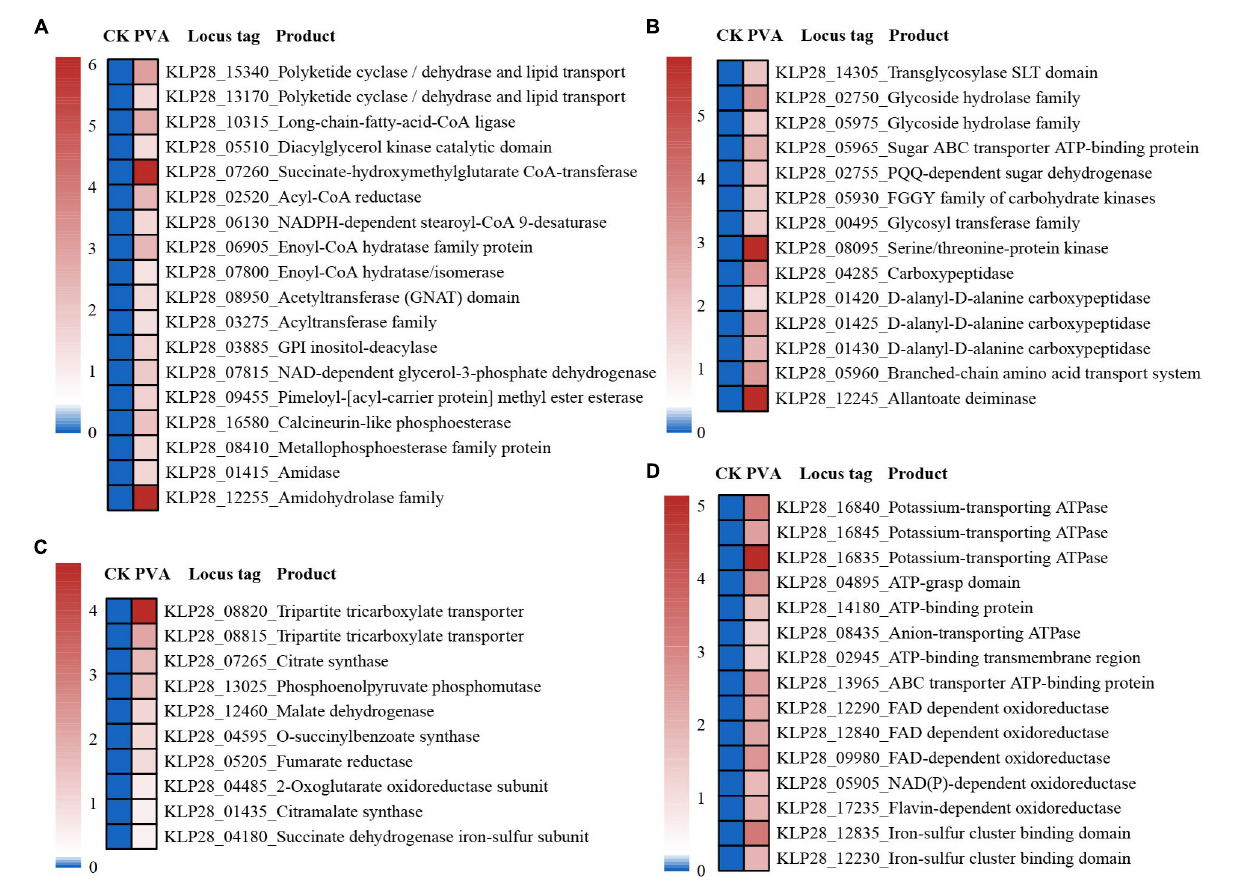
FIGURE 5 | Transcriptomic analysis of essential metabolic pathways for energy production in strain TYQ2 that cultured in the medium supplemented with PVA. (A) A heat map based on transcriptomics analysis showing the up-regulated genes related to lipid metabolism. (B) A heat map based on transcriptomics showing all the up-regulated genes associated with sugar/amino acid/nucleotide metabolism. (C) A heat map based on transcriptomics analysis showing all up-regulated genes related to tricarboxylic acid cycle. (D) A heat map based on transcriptomics analysis showing all up-regulated genes encoding proteins associated with ATP